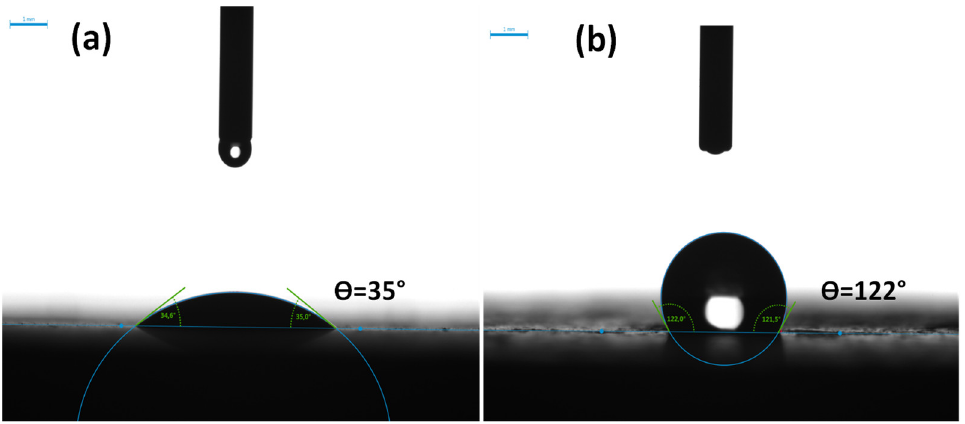
Figure 12. Water drop shape at the surface of ( a ) h-BN and ( b ) BNO Cal/W /Si-PMMA. Wetting parameter calculations: According to thermodynamics law, interfacial tensions between each component of a system containing PMMA, PA6, and h-BN govern the localization of h-BN fillers in the immiscible polymer blend. The determination of the wetting parameter ( Ꞷ AB ) is possible using the interfacial tensions between the components (Equation (1)) [69].